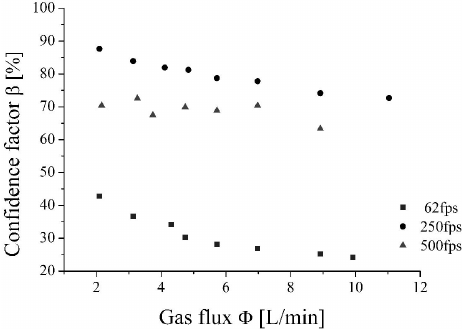
Fig. 4. The ratio β shows the flux dependent accuracy of bubble as- signment with an assignment of 85% decreasing to 75% for 250fps. At 500fps β remains approximately constant for all flow rates while for 62fps most of the bubbles cannot be assigned